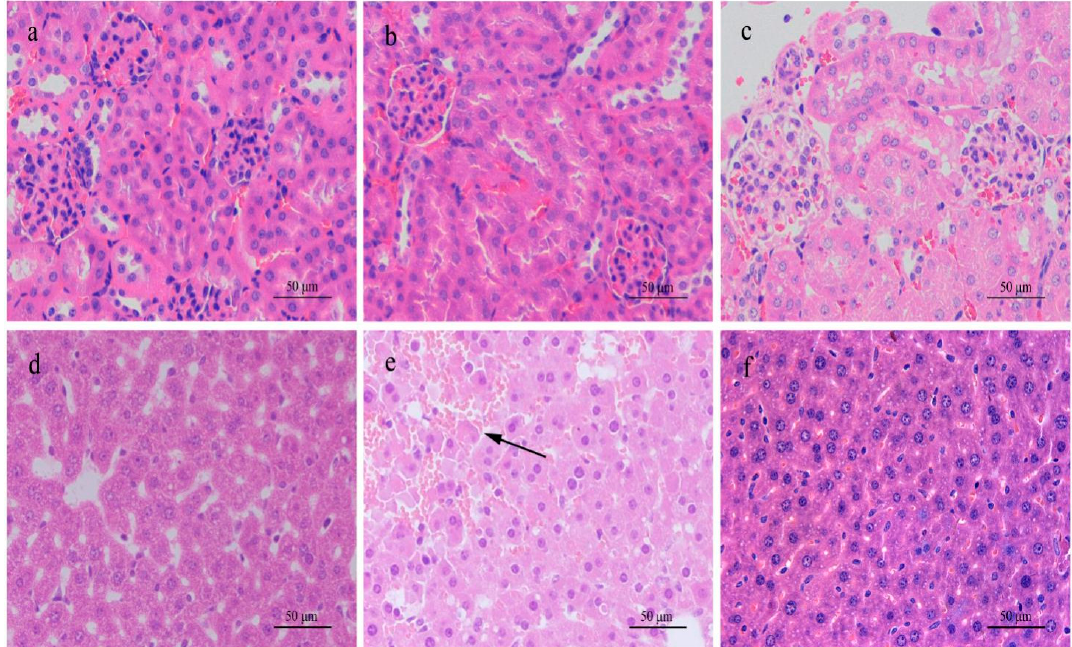
Figure 2. H & E stained histological sections of the kidneys and livers of mice exposed to different concentrations of MC-RR for 24 h. ( a ) Kidney in 0.0 μ g/kg MC-RR group (control group). ( b ) Kidney in 210.0 μ g/kg MC-RR group. ( c ) Kidney in 105.0 μ g/kg MC-RR group. ( d ) Liver in 0.0 μ g/kg MC-RR group (control group). ( e ) Liver in 210.0 μ g/kg MC-RR group. Sinusoid expansion and hyperemia (arrow). ( f ) Liver in 105.0 μ g/kg MC-RR group.